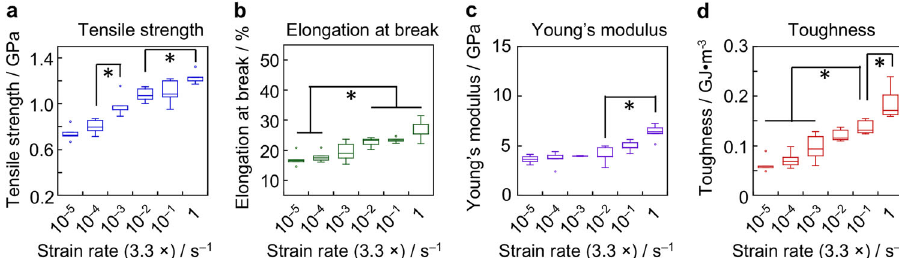
Fig. 2 Effects of strain rates on mechanical properties of spider dragline silk fi bers. Mechanical properties of dragline silk fi bers at RH43% under strain rates ranging from 3.3 × 10 − 5 to 3.3 s − 1 : a Tensile strength, b elongation at break, c Young ’ s modulus, and d toughness. *Signi fi cant differences between groups at p < 0.05.